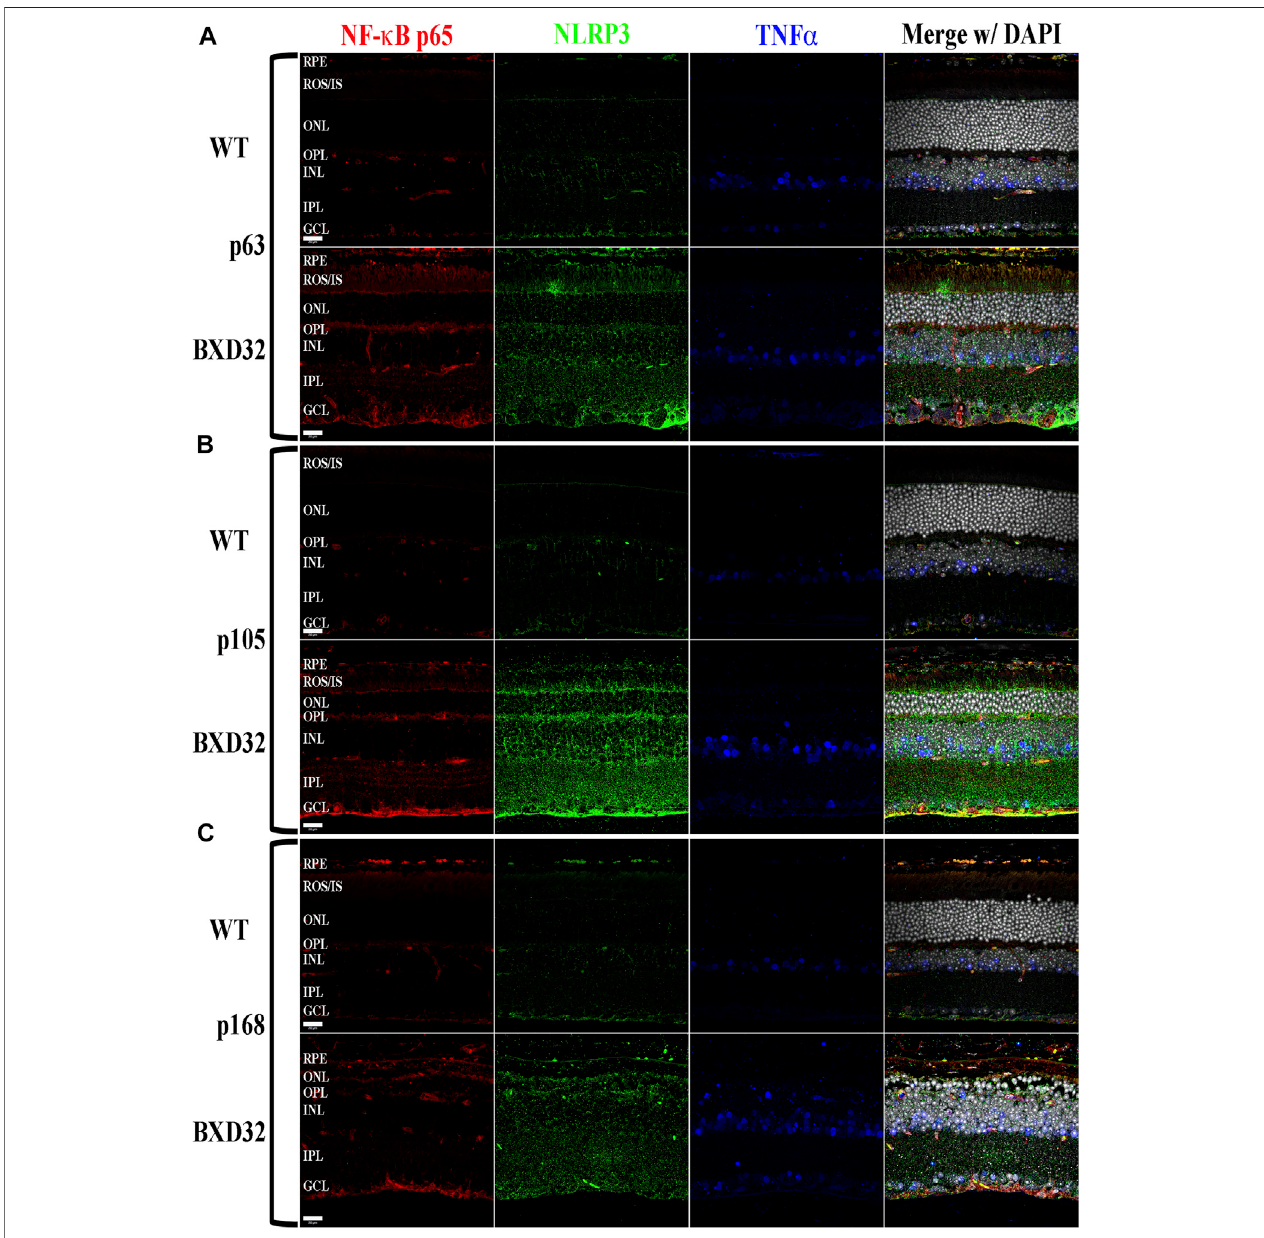
FIGURE7| Theproin fl ammatorycytokineTNF α andoneofitscognatepathways,theNF- κ B/NLRP3in fl ammasome,aresubstantiallyupregulatedandactivatedin the BXD32 mouse retina. Using immunolabeling for NF- κ B p65 (red), NLRP3 (green), and TNF α (blue), the BXD32 mouse retina displays upregulated levels of all three proteinsexaminedbeginningasearlyasp63 (A) andcontinuingthroughp105 (B) andp168 (C) ,indicatingachronicproin fl ammatoryretinalenvironment.Nucleistained with DAPI (white/grey). RPE, retinal pigment epithelium; ROS/IS, rod outer segments/inner segments; ONL, outer nuclear layer; OPL, outer plexiform layer; INL, inner nuclear layer; IPL, inner plexiform layer; GCL, ganglion cell layer. Scale bars = 20 μ